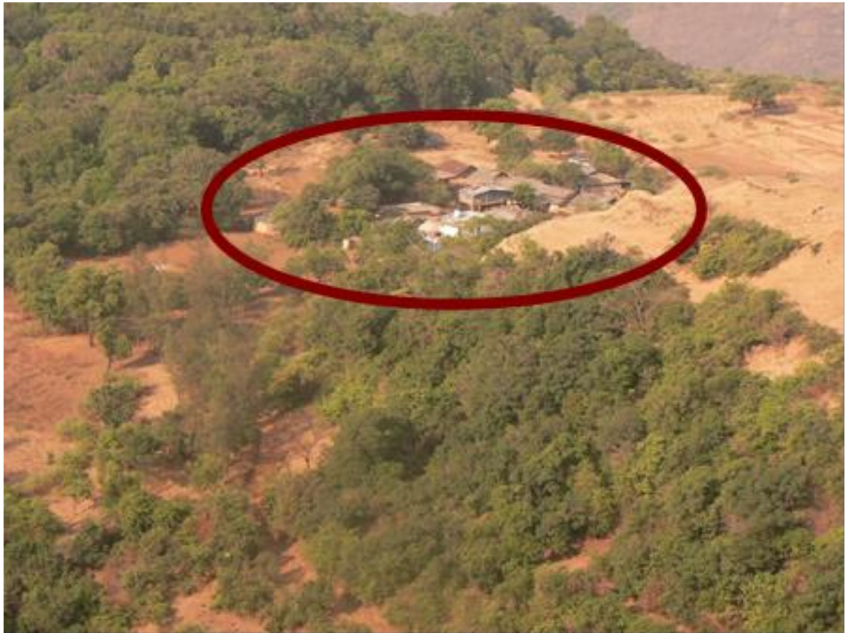
Figure 3. An aerial view of Rajmachi village, Maharashtra (circled in red).